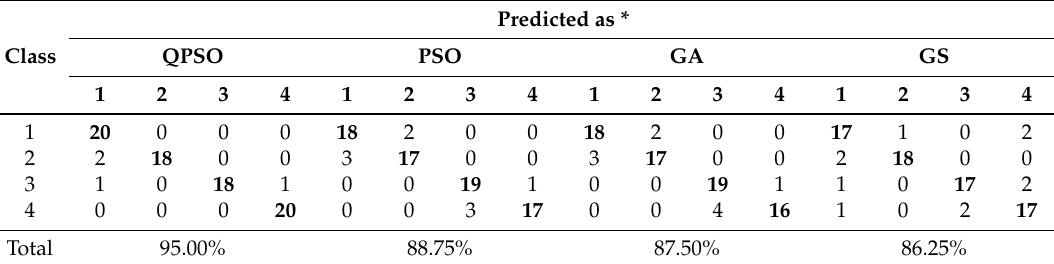
Table 5. Comparison with different optimization methods for KELM.